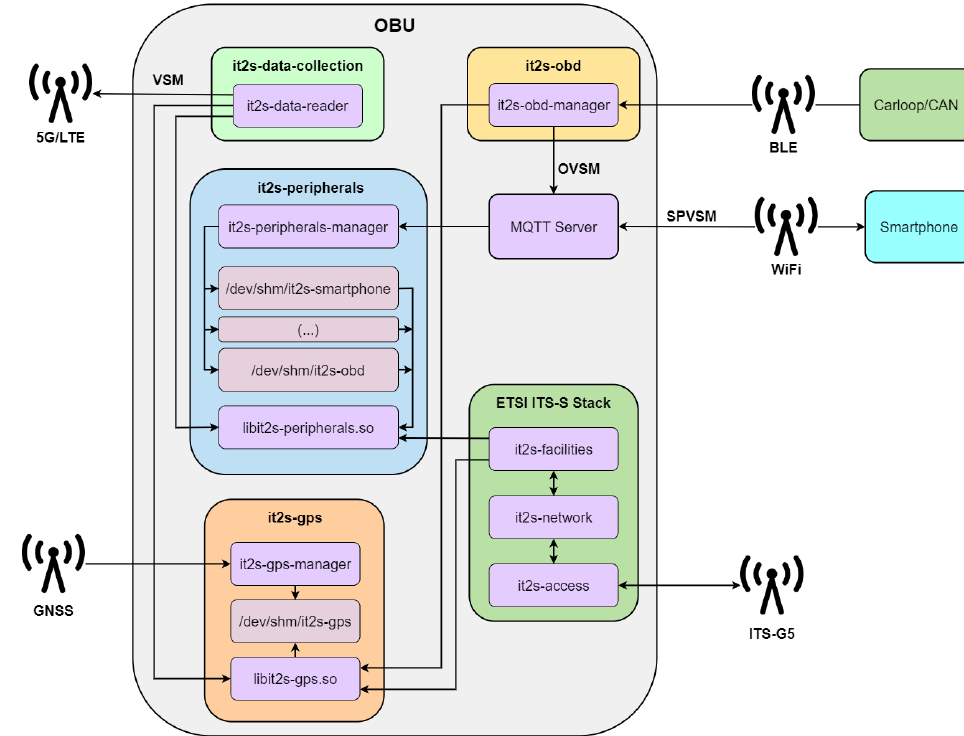
Figure 7. OBU’s internal architecture and